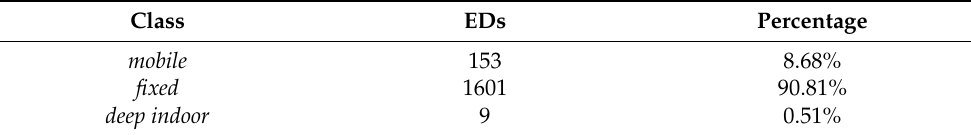
Table 3. Distribution of the filtered EDs between the three